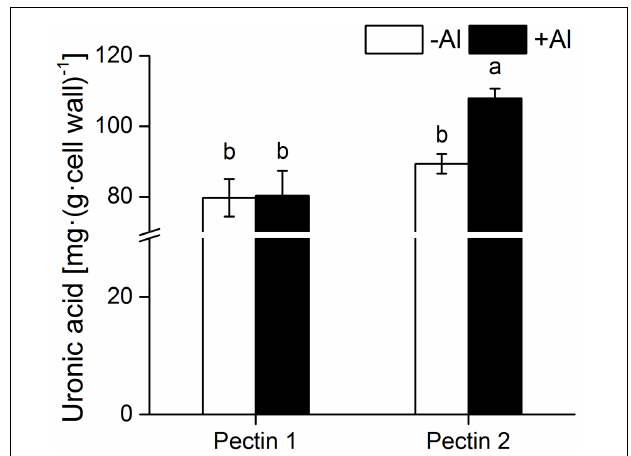
FIGURE 4 | Content of uronic acids in cell wall pectin. Pectins 1 and 2 were extracted from cell wall samples of RBCs. The uronic acids content was determined using hydroxydiphenyl colorimetry. Different lowercase letters indicate significant differences at p < 0.05 for the same treatment.